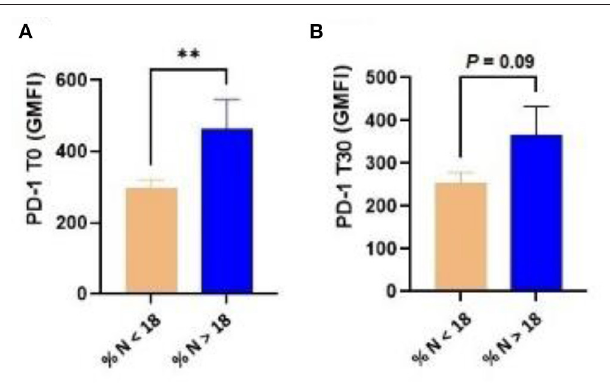
FIGURE 2 | Dairy cows diagnosed with cytological endometritis [i.e., percentage of neutrophils higher than 18 (% N > 18)] at T30 had a higher expression of PD-1 in blood T lymphocytes at both T0 (A) and T30 (B) . PD-1, programmed cell death protein 1; T0 = day of delivery; T30 = 30 days postpartum; GMFI, geometric mean fluorescence intensity. ** P <